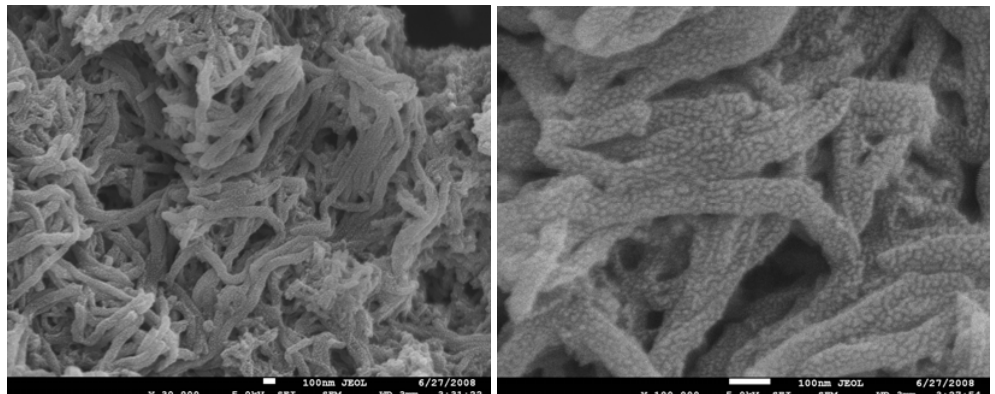
Figure 2. SEM image of PANI:PESA showing ~90 nm (diameter)